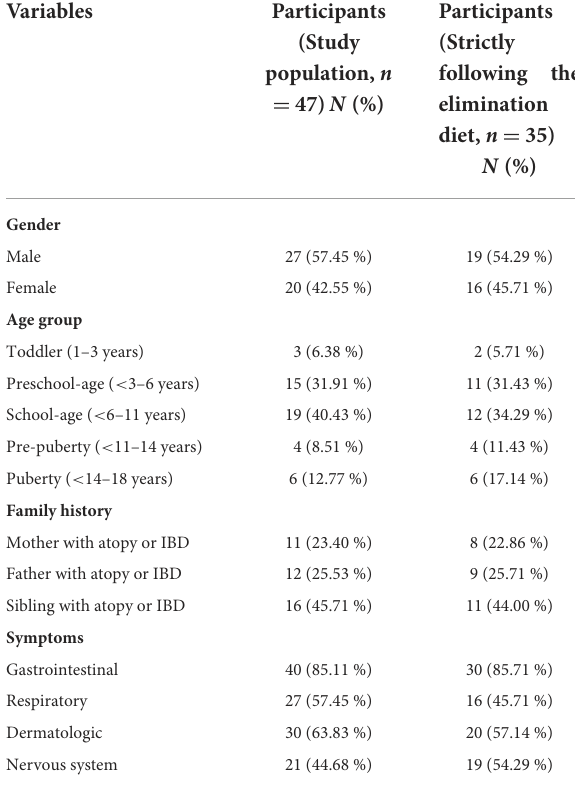
TABLE 1 Demographic and clinical data of study